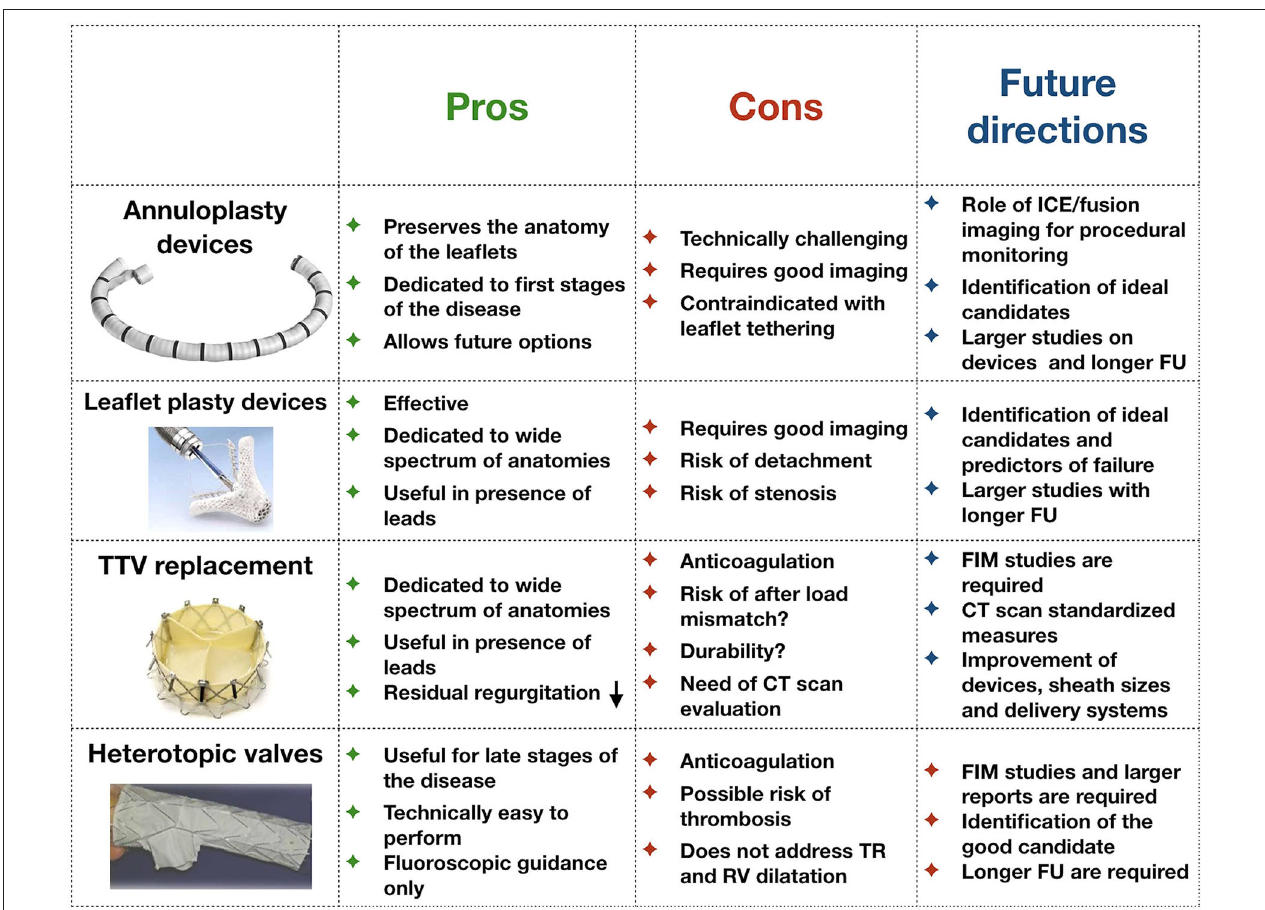
FIGURE 2 | Pros and cons of each kind of technology currently under development for the treatment of tricuspid regurgitation. FU, follow-up; FIM, first-in-man studies; TR, tricuspid regurgitation; CT, computed tomography.